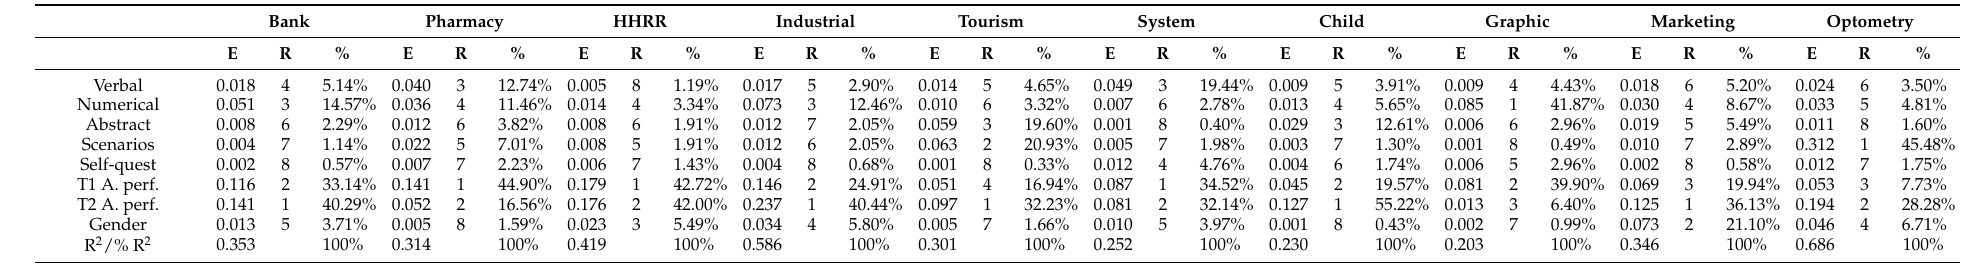
Table 5. Results of general dominance analyses for T3 academic performance separately by